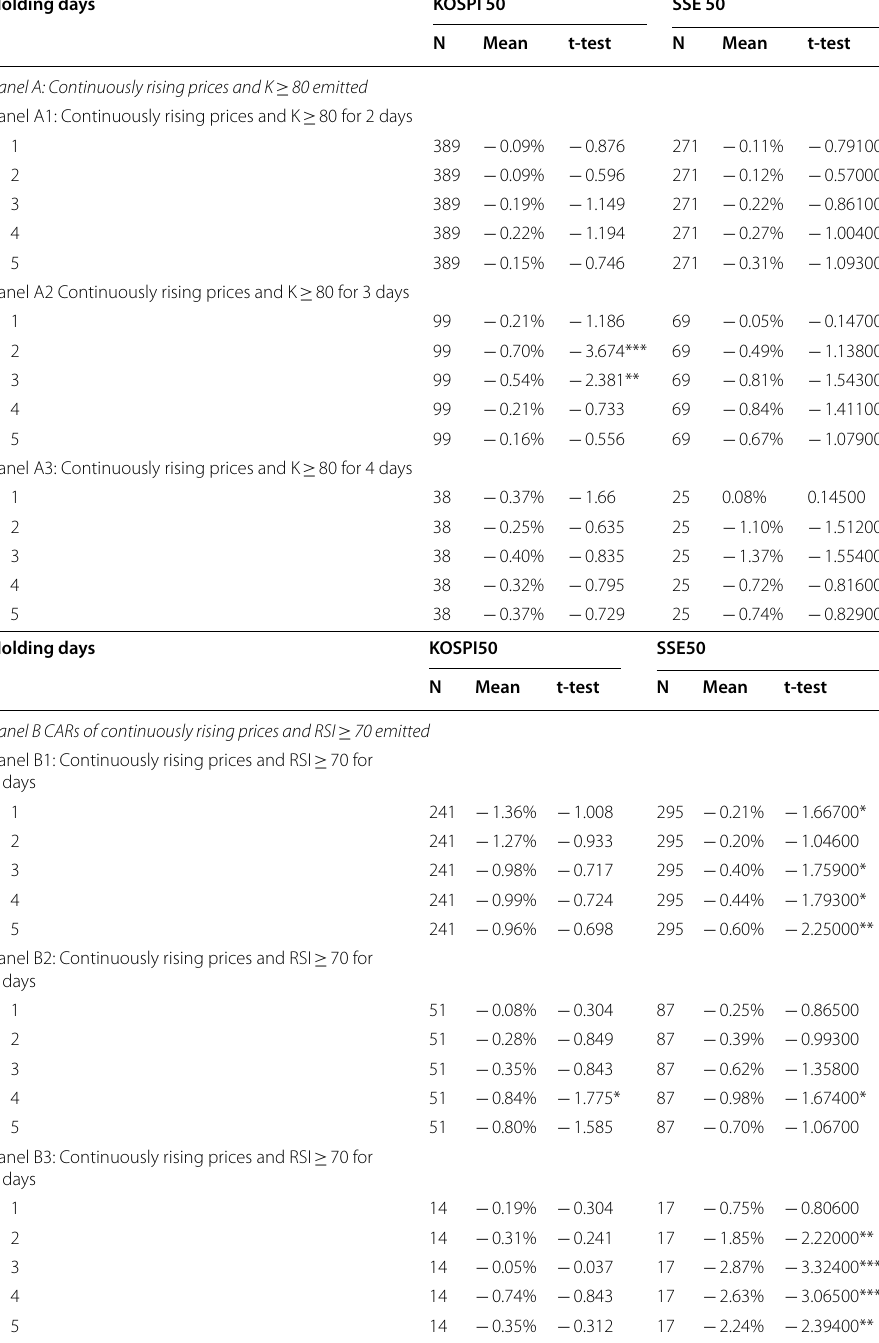
Panel A: Continuously rising prices and K Panel A1: Continuously rising prices and K